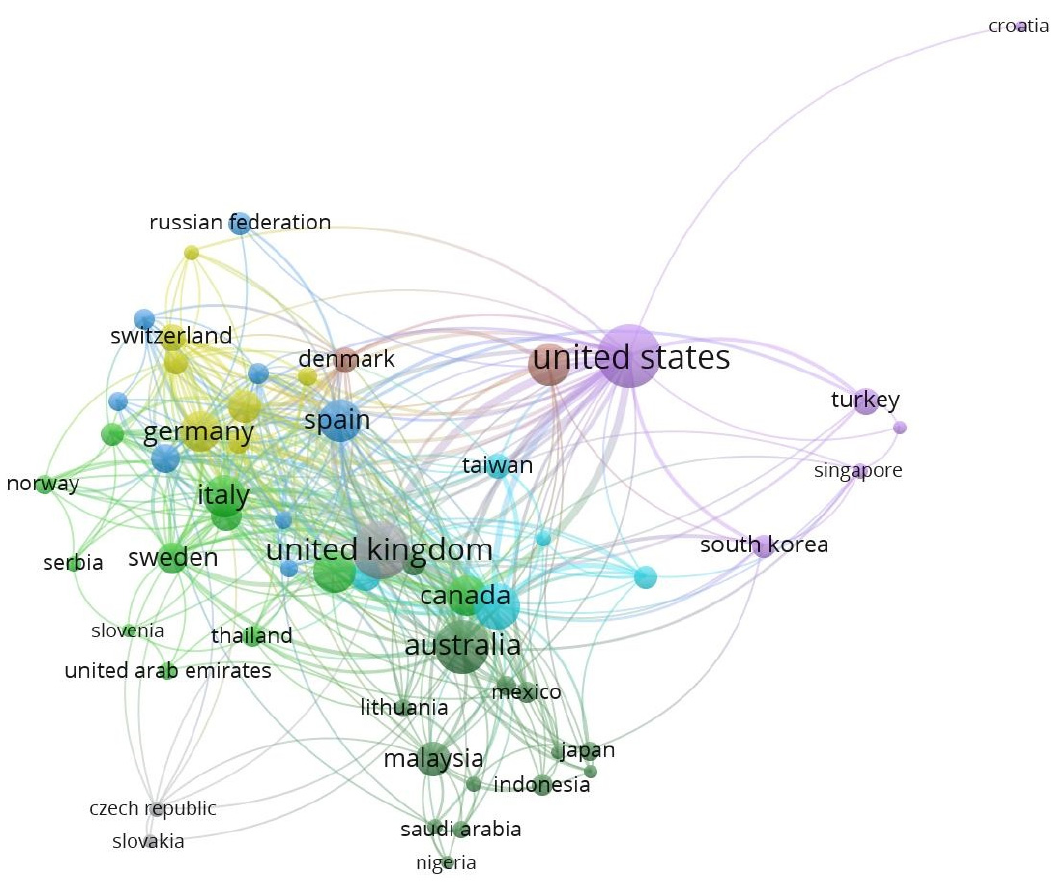
Figure 5. Network of cooperation between countries based on co-authorship (1988–2019).